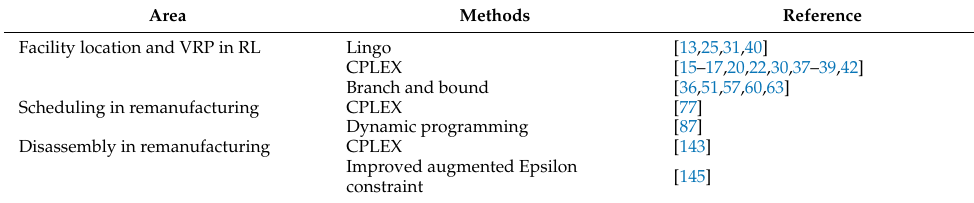
Table 5. Exact algorithms.